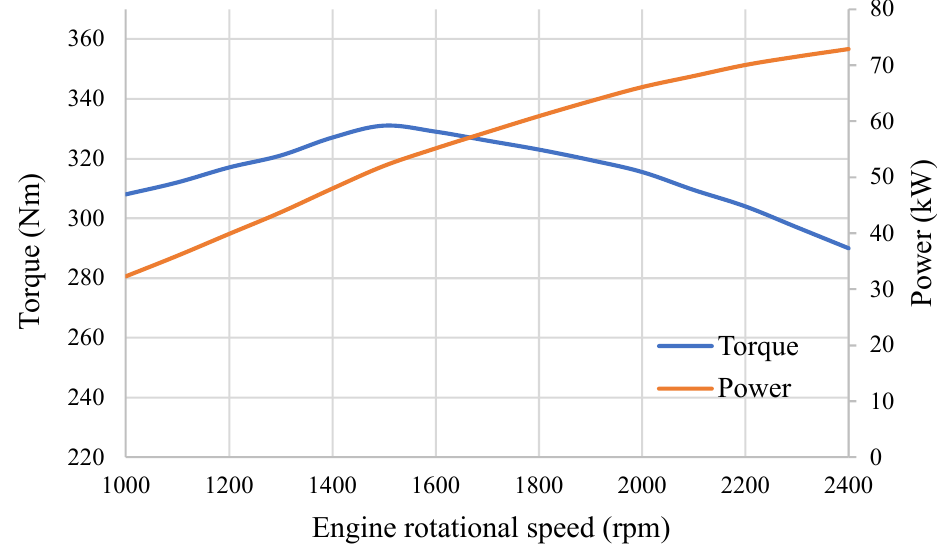
Figure 2. Torque and power characteristics for the diesel engine of the conventional